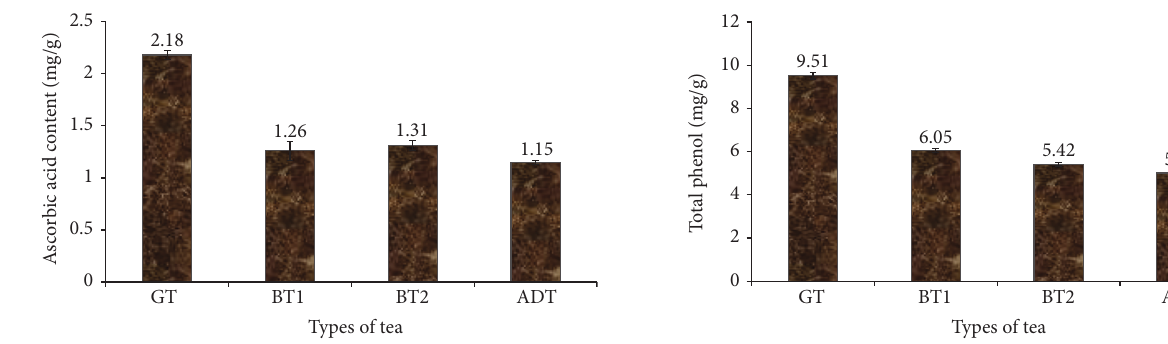
Figure 1: Ascorbic acid content of some commercially available tea. GT: Green tea; BT: Black tea; ADT: antidiabetes tea.